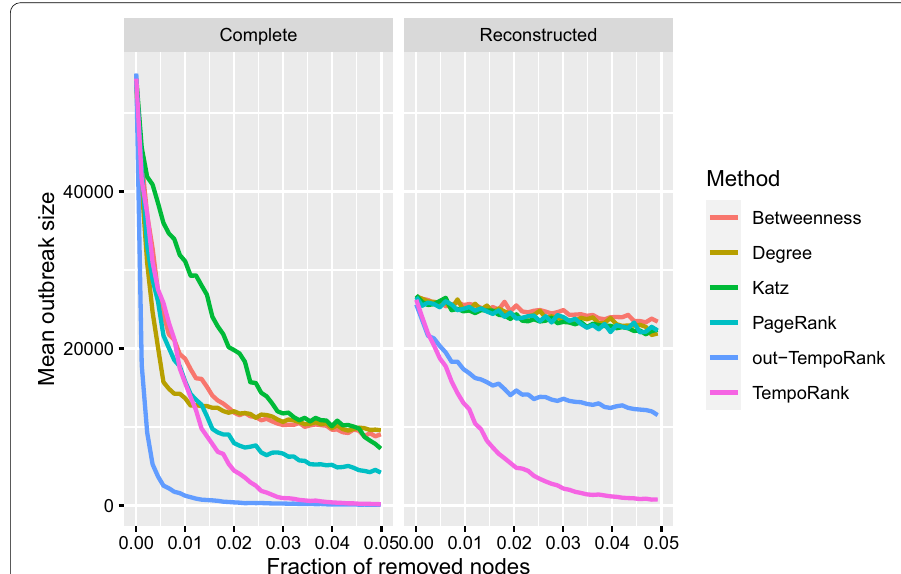
Fig. 8 Mean final outbreak size over 10,000 simulations for an infection on the 2015 networks, with nodes removed according to the centrality computed on the corresponding 2014 network (linear